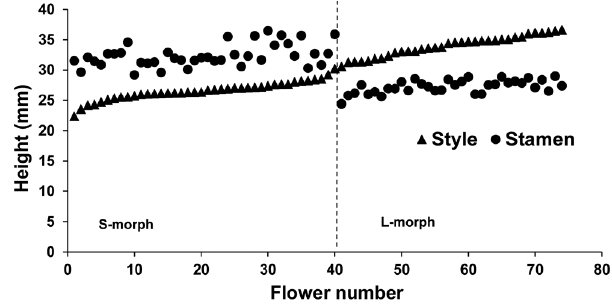
Figure 3 – Patterns of variation in style and stamen height in S-morph and L-morph flowers of C. subcordata. Styles are indicated by solid triangles and stamens are indicated by solid circles. The dotted line in the middle separates the two floral morphs: the S-morph flowers are on the left, while the L-morph flowers are on the right. The x-axis shows the flowers investigated numbered from 1 to